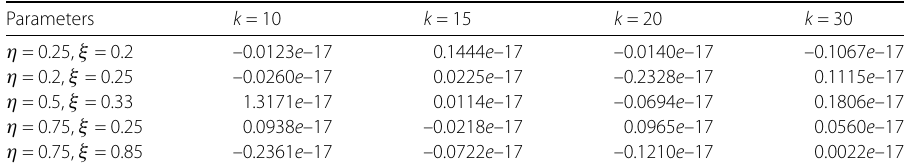
Table 1 Absolute error in boundary conditions of u ( t ) of Example 6.1 using different choice of parameters Parameters k = 10 k = 15 k = 20 k = 30 η = 0.25, ξ = 0.2